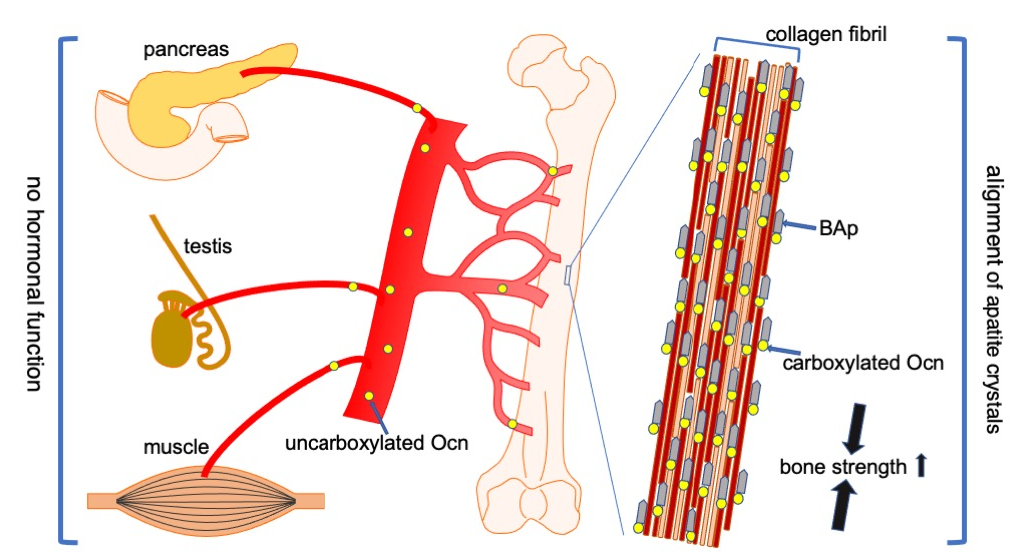
Figure 2. Functions of Ocn in bone, pancreas, testis, and muscle. Carboxylated Ocn is required for the alignment of BAp parallel to the collagen fibers and optimal bone strength. However, two newly generated Ocn − / − mouse lines and Ocn − / − rats did not exhibit the impaired glucose metabolism, reduced testosterone synthesis and spermatogenesis, and reduced muscle mass observed in the Ocn − / − mouse line generated by Karsenty’s group. Thus, uncarboxylated Ocn does not physiologically function as a hormone that regulates glucose metabolism in the pancreas, testosterone synthesis in testis, or muscle mass. ↑ : Bone strength is increased by carboxylated Ocn.